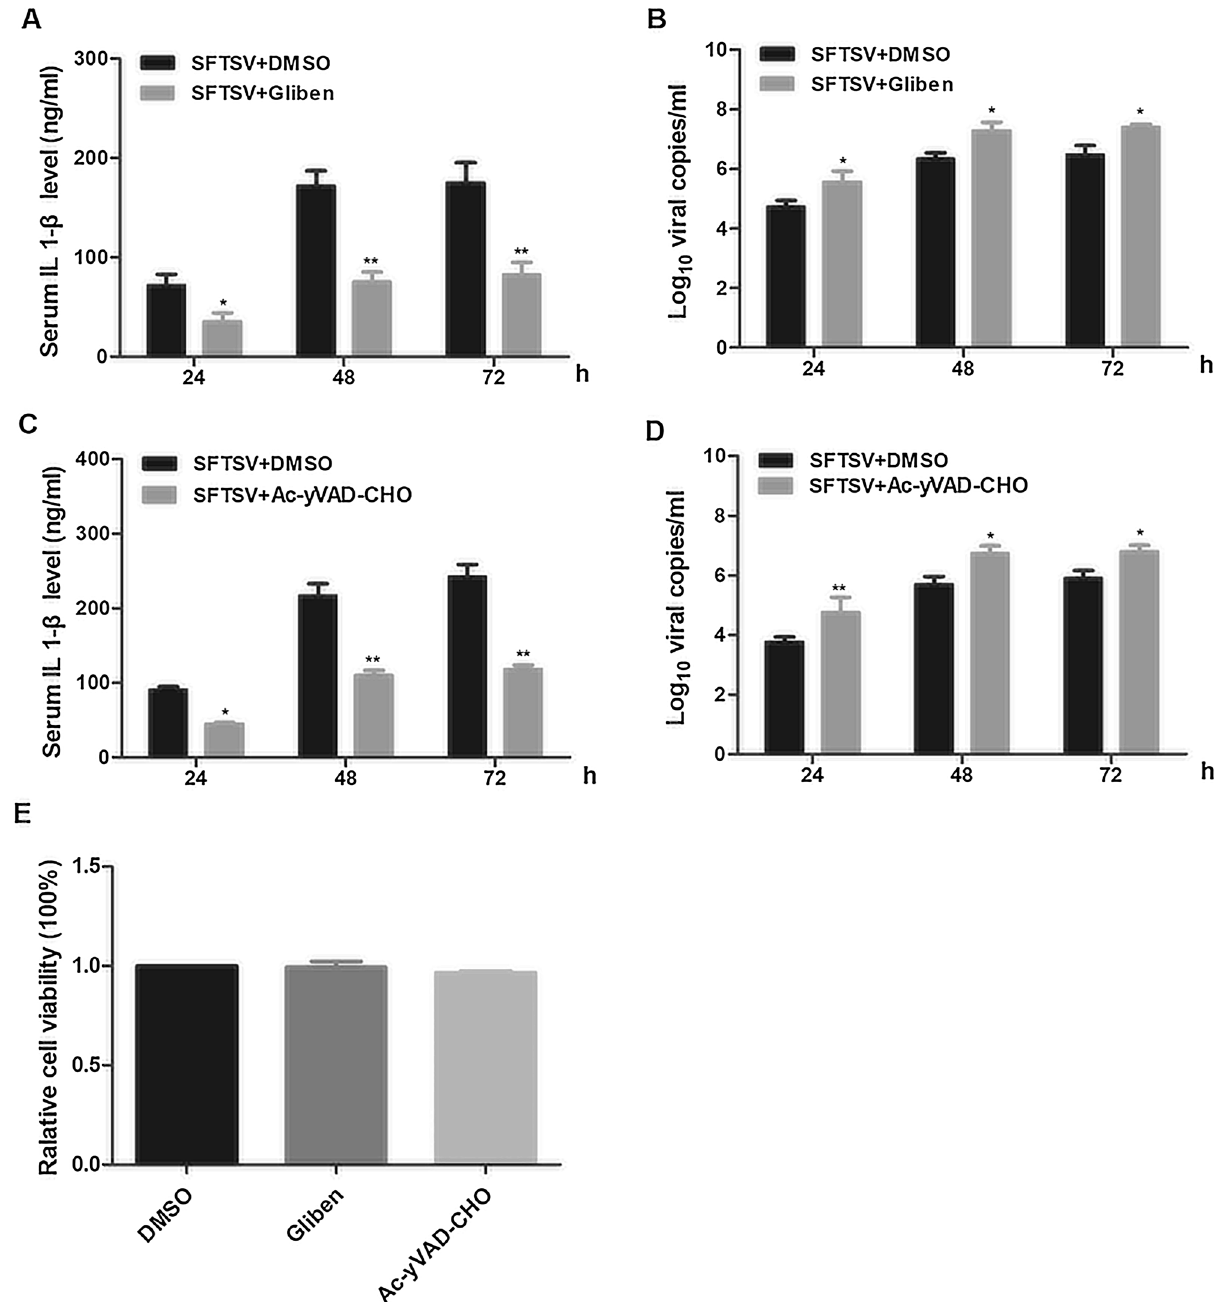
Figure 5. Effect of functional NLRP3 and caspase-1 on viral replication and IL-1β secretion in human PBMCs infected with SFTSV. Glibenclamide, an NLRP3-specific inhibitor, and Ac-YVAD-cmk, an inhibitor of caspase-1, were used to pre-treat PBMCs, prior to viral infection, to show their impact on IL-1β secretion and viral replication. ( A , B ) PBMCs were treated with glibenclamide (1 μM) or DMSO for 6 h, followed by infection with SFTSV (MOI = 1). IL-1β levels were determined in the culture medium at 24, 48, and 72 h pi by ELISA ( A ) and viral RNA copy numbers were measured in the total RNA extracted from the cells by real-time PCR with primers for the viral S genome ( B ). The ( C , D ) PBMCs were pre-treated with Ac-YVAD-cmk (1 μM) or DMSO for 6 h, followed by viral infection (MOI = 1). IL-1β levels were determined by ELISA ( C ) and the viral RNA copy numbers measured by real-time PCR ( D ). ( E ) No effect of glibenclamide (1 μM) or Ac-YVAD-cmk (1 μM) on liability of PBMCs were detected as determined with CCK-8 assays. The presented data were mean ± SD; n = 3; P-values were calculated using a One-way ANOVA test (* P < 0.05; ** P < 0.01; *** P <